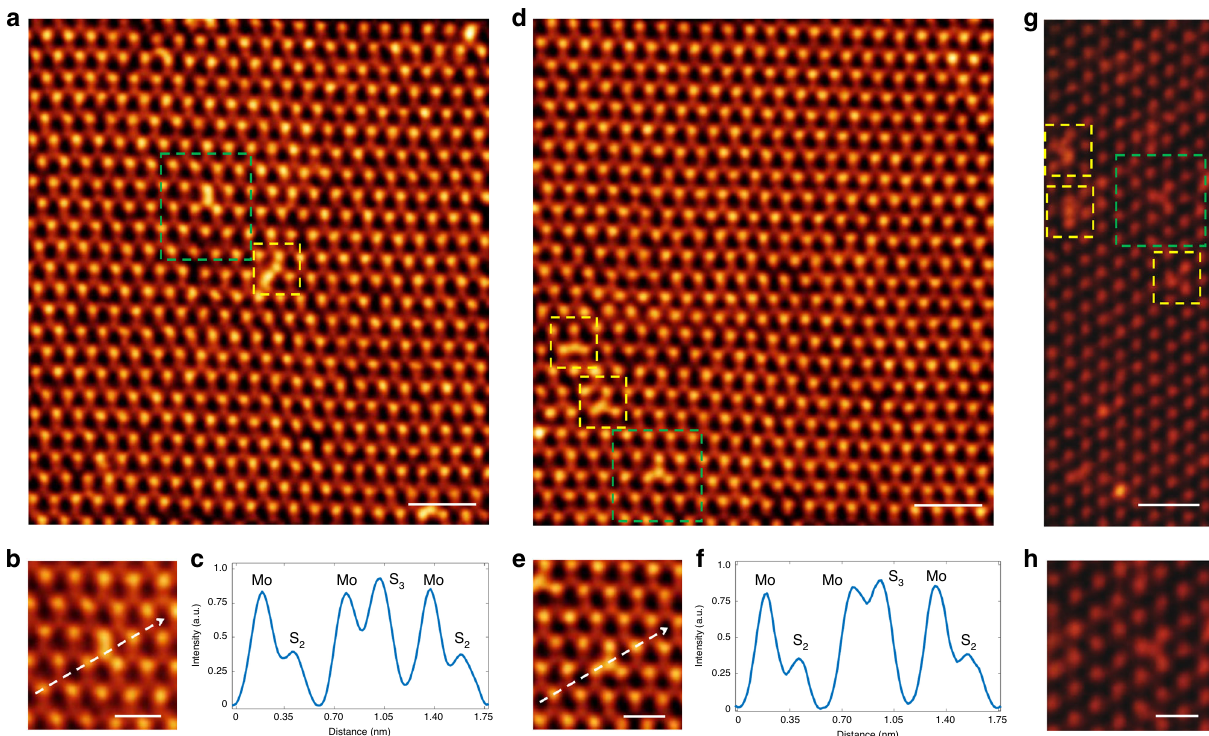
Fig. 4 STEM characterization of HCl/H 2 O p-type defects in MoS 2 . a HAADF STEM lattice image of a CVD-grown monolayer MoS 2 fl ake heated in HCl/ H 2 O for p-character treatment, as described in the main text. As a result of the mass contrast behavior (~ Z 2 , where Z = atomic number) of HAADF imaging, Mo atoms ( Z = 42) appear as bright spots in a 2H (trigonal prismatic) coordination with S 2 ( Z = 32) lattice sites. We observe the presence of dopants (outlined in green and yellow) that are not seen in pristine, untreated samples. b High-magni fi cation STEM image of an individual dopant from ( a ) (outlined in green), in which a noticeable increase in contrast is detected at a chalcogen lattice site. c Intensity pro fi le across the dopant site reveals an intensity rise that is consistent with an additional protruding S atom, the S 3 dopant. d – f Numerous dopants observed across different CVD MoS 2 fl akes demonstrate similar structural and contrast features. g , h HAADF STEM lattice image of an exfoliated monolayer MoS 2 fl ake exposed to p-character treatment, showing S 3 dopants. Scar bar: 1 nm in ( a ), ( d ), and ( g ); 500 pm in ( b ), ( e ), and ( h